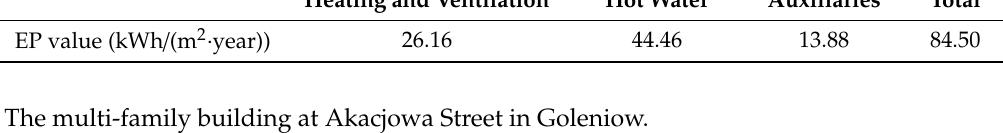
Table 7. The annual final energy demand EK (kWh / (m 2 · year)) for the multi-family building at Akacjowa Street in Goleniow. Energy Carrier Heating and Ventilation Hot Water Auxiliaries Total District heating ( w = 0.92) 29.37 50.56 0.00 81.25 Mains electricity ( w = 3.0)